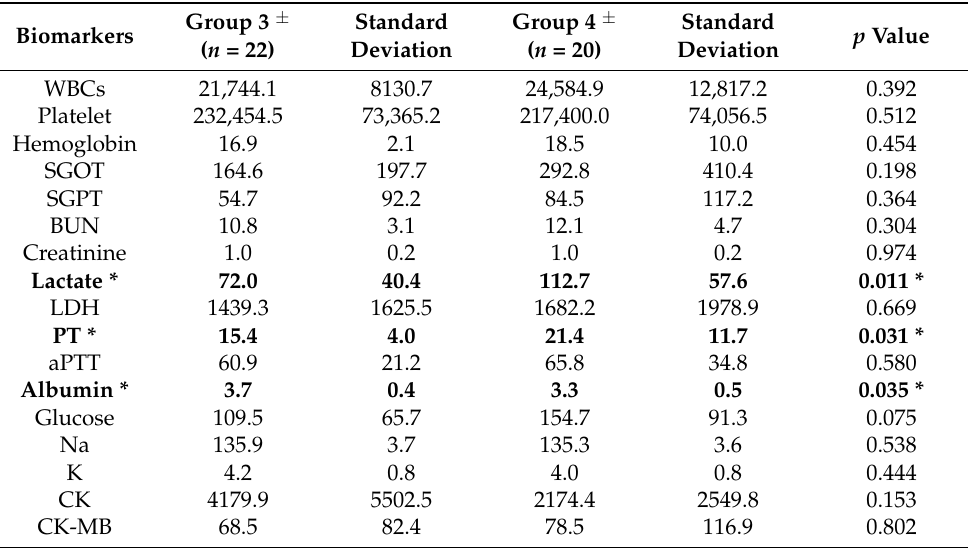
Table 4. Differences in blood biomarkers correlated with MRI results after hypothermia rescue therapy in 42 patients with neonatal